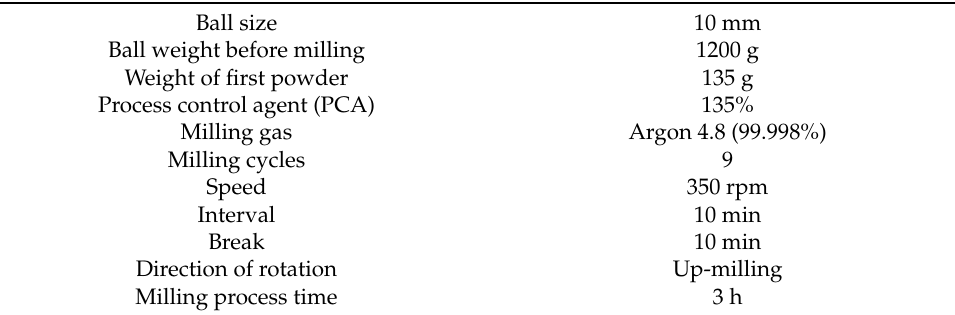
Table 1. The milling conditions of Fe–Co